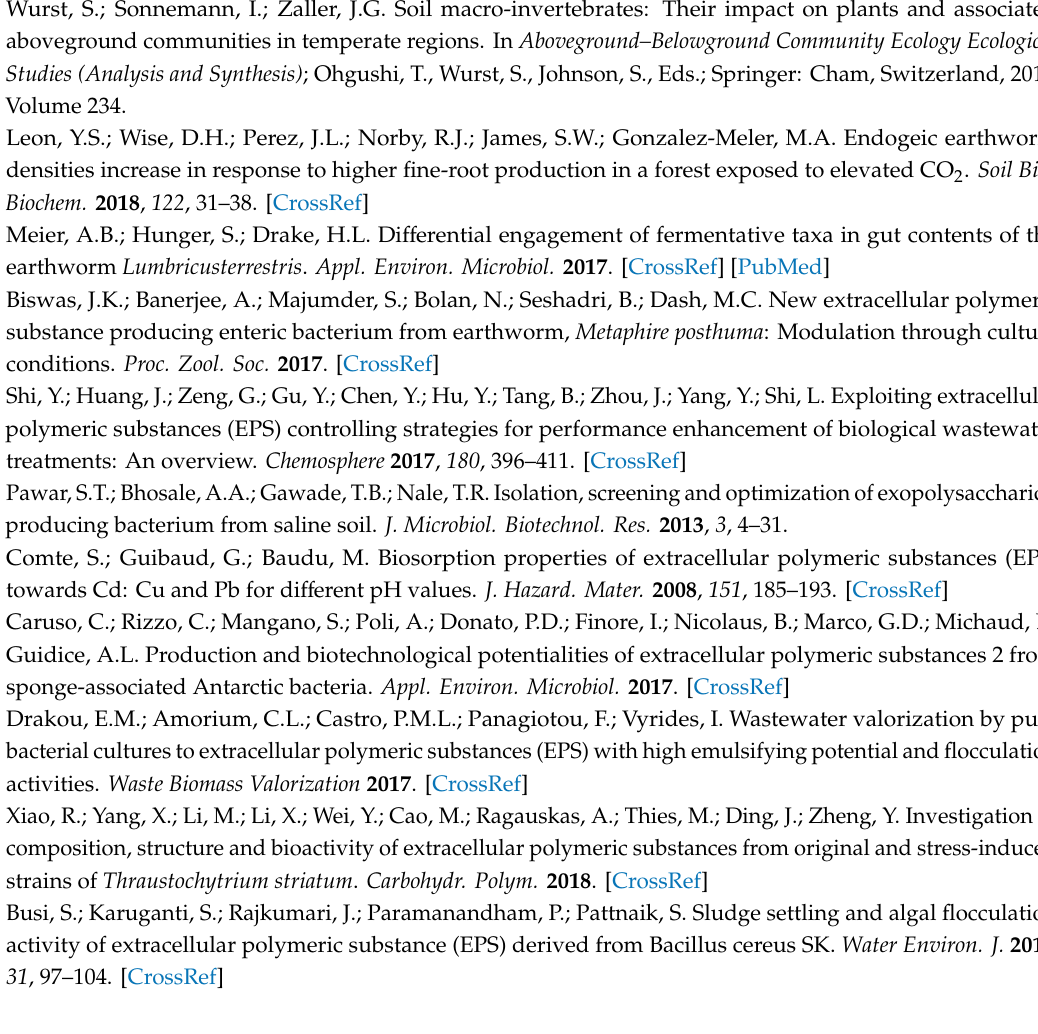
Figure S1: The isolation of the bacteria with a characteristic slimy, mucoid phenotypic nature from the gut of the earthworm Metaphire posthuma , Figure S2. Atomic absorption spectroscopy (AAS) standard curve for metals Cu(II) and